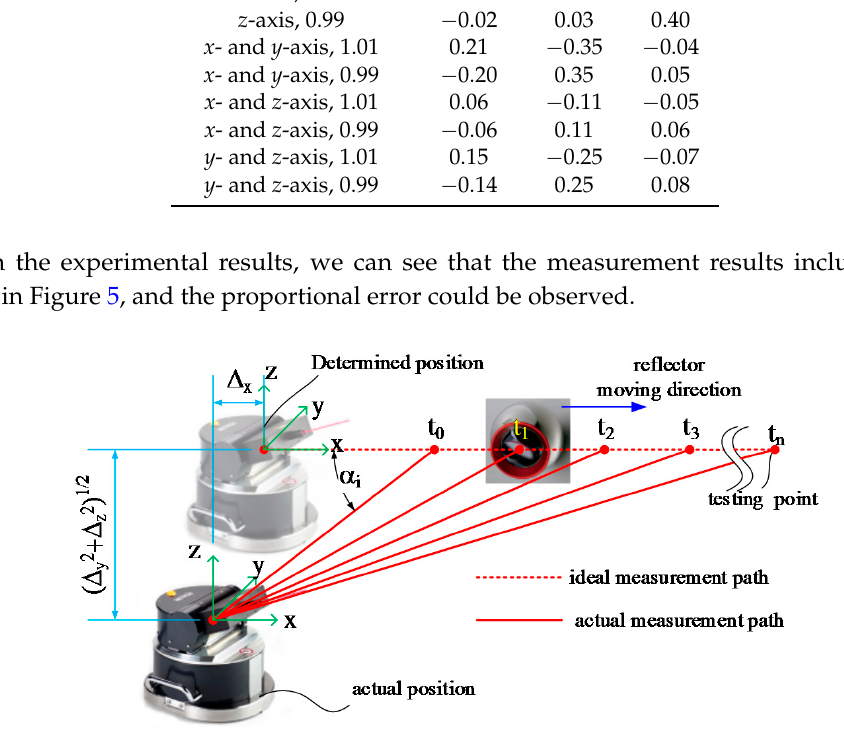
Figure 5. If the actual and determined positions of the ATLI are different, the measurement difference becomes smaller over the measurement distance. In the figure, t 0 to t n represent the number of target point to be tested.